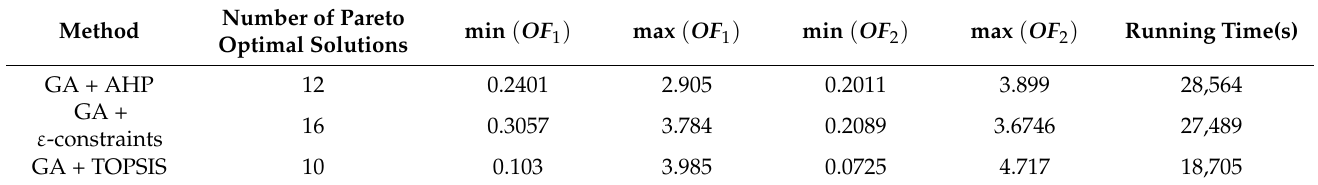
Table 6. Comparison of the obtained optimal Pareto fronts from different